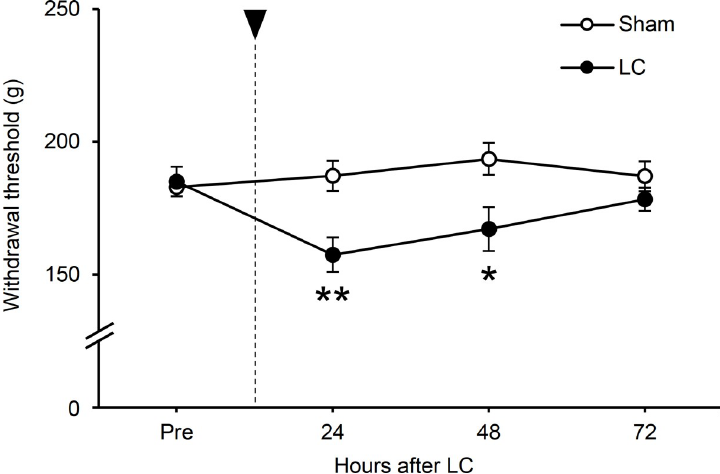
Fig 1. Induction of muscular mechanical hyperalgesia using lengthening contractions (LC). Changes in the mechanical withdrawal threshold of the exercised muscle. Black arrow indicates the time point of LC. Abscissa: hours after LC. Ordinate: muscular mechanical withdrawal threshold (in grams). A significant reduction in the threshold occurred at 24 and 48 h after LC (n = 6 rats in each group, � P < 0.05 and �� P < 0.01 vs. Sham, two-way repeated measures ANOVA followed by Student’s t-test).